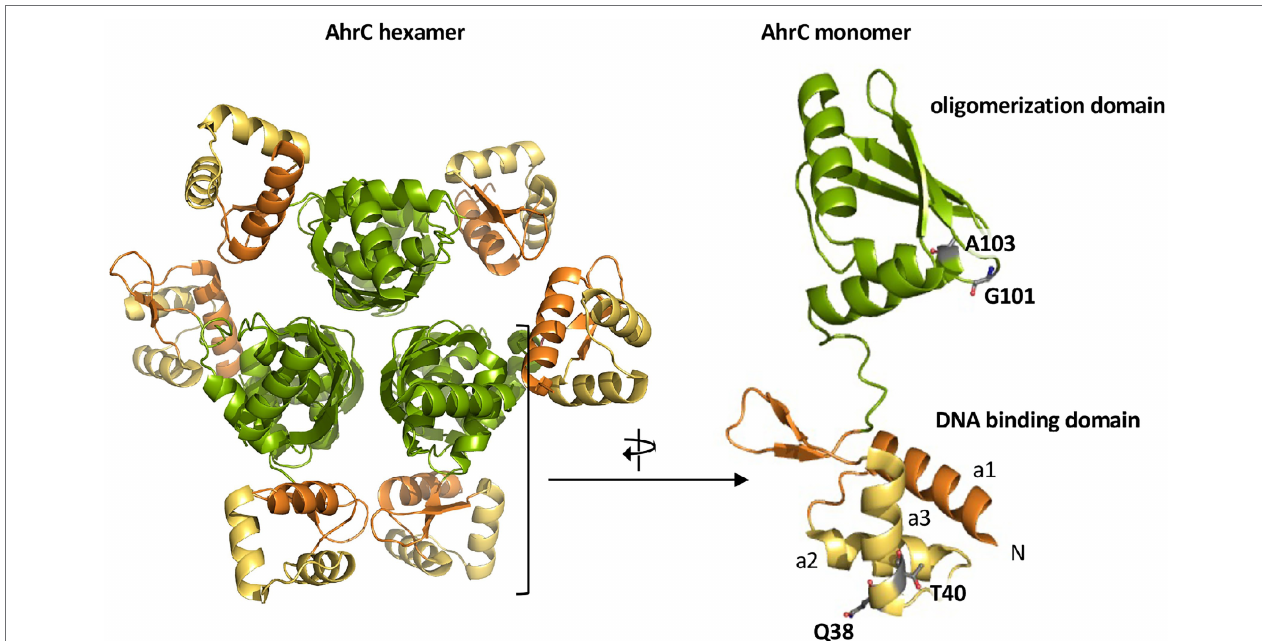
FIGURE 6 | Crystal structure of the AhrC regulatory protein. The B. subtilis AhrC protein is a homo-hexamer and its monomer possesses two functionally distinct domains that are connected by a flexible linker region (Dennis et al., 2002). The N-terminal domain is involved in DNA-binding and contains a winged helix-turn-helix DNA-binding motif (yellow); the C-terminal part represents the effector (L-arginine) and multimerization domain (green; Garnett et al., 2007a,b). The representation of the AhrC hexamer and monomer was rendered using PyMol (Delano, 2002) and by using structural information deposited in the RCSB Protein Data Bank (pdb code: 1F9N). The positions of four single amino acid substitutions in AhrC leading to an osmostress-tolerant growth phenotype ( Table 3 ) are